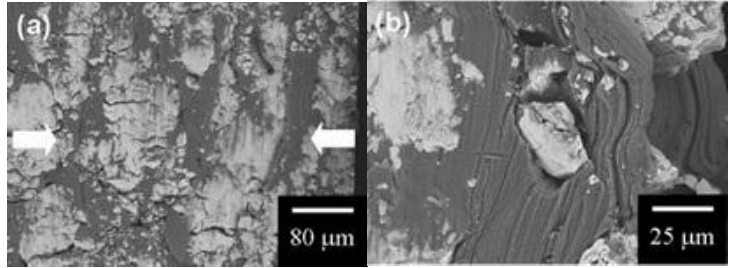
Figure 6. Fractographs of Zr-based metallic glass reinforced Al composites. ( a ) Low magnification image with loading direction indicated by arrow; ( b ) particle breakage (reprinted from Scudino et al . 2009 [8], with permission from ©